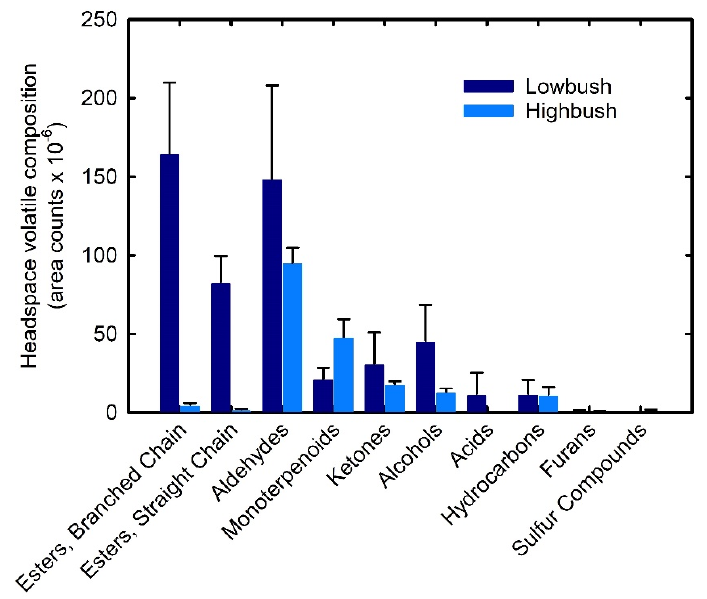
Figure 1. The distribution of volatile compounds in the headspace of wild lowbush and cultivated highbush blueberry fruit grouped according to chemical properties. Values represent the mean area counts collected from wild lowbush fruit samples from three commercial fields located in four provinces in eastern Canada (n = 12) and five cultivars of cultivated highbush fruit collected from three fields and two harvests (n = 30).